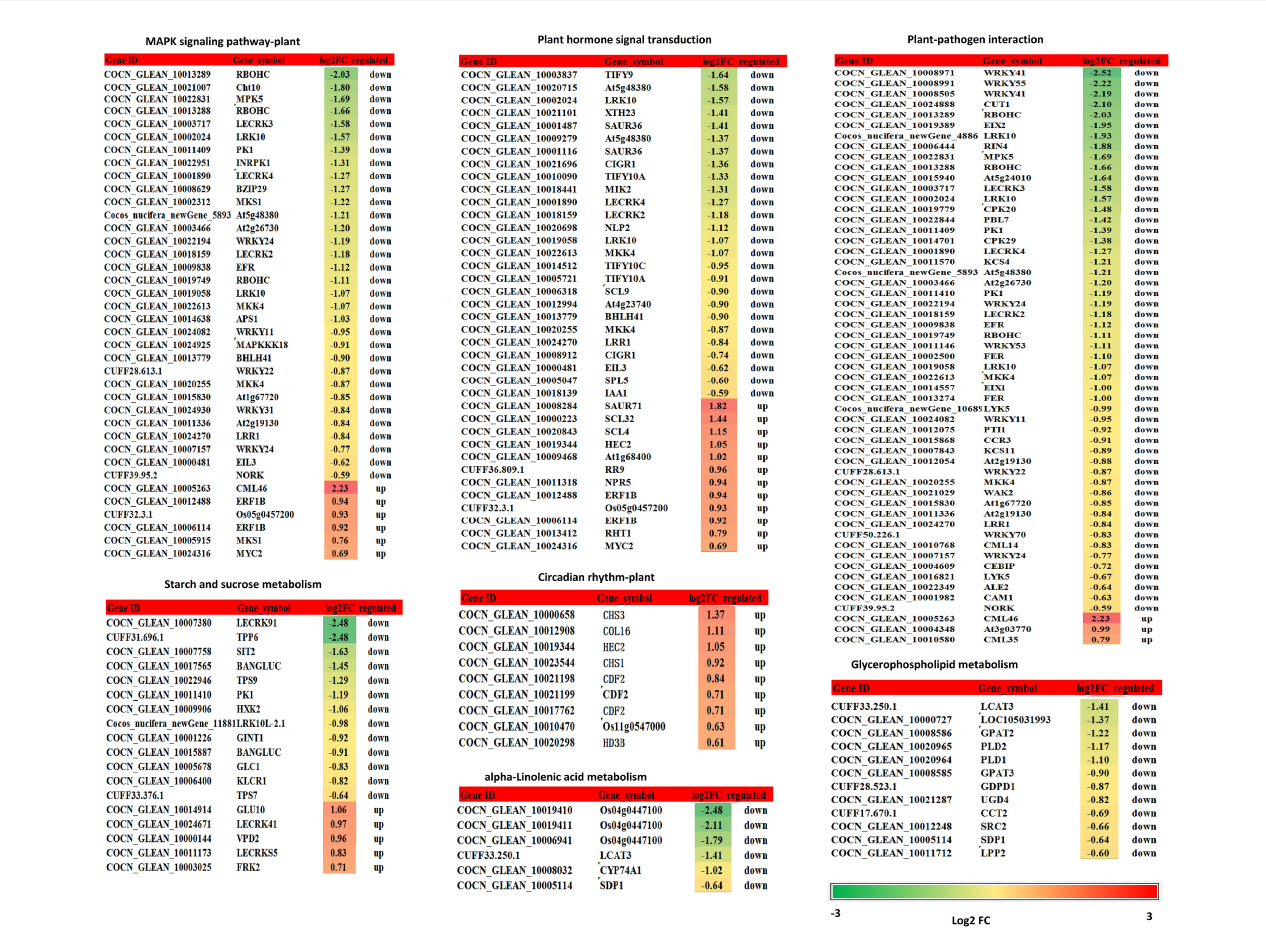
FIGURE 6 DEGs related to the MAPK signaling pathway - plant, starch and sucrose metabolism, plant hormone signal transduction, plant-pathogen interaction, glycerophospholipid metabolism, alpha-linolenic acid metabolism, circadian rhythm - plant. Changes in relative expression under K + de fi ciency (log2FC based on mean RPKM in K 0 vs. K ck ) are shown as a color gradient from low (green) to high (red). Log2(FC) > 0 indicates upregulation, log2(FC) < 0 indicates downregulation, and log2(FC) = 0 indicates unchanged